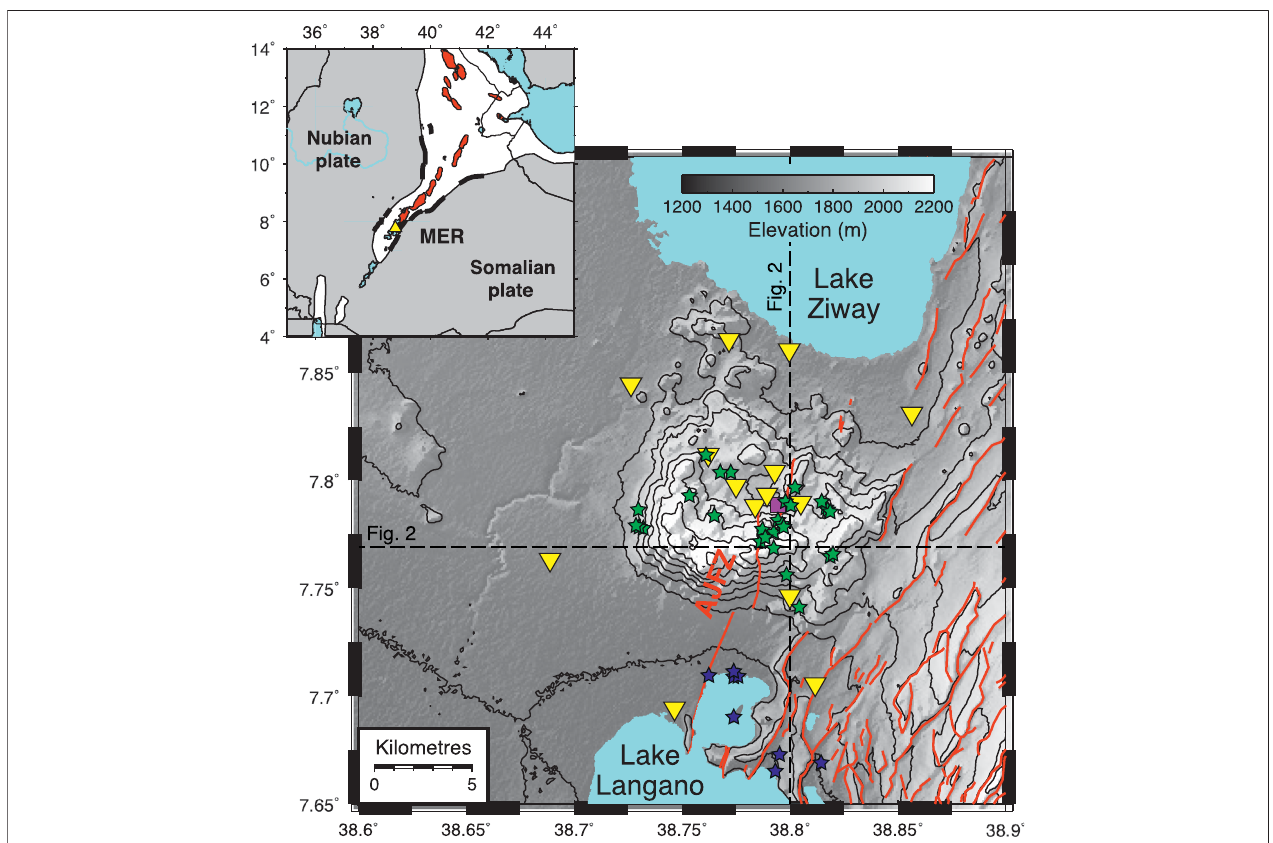
FIGURE1 | The ARGOS seismic network (yellow triangles), faults (red lines) (Agostiniet al., 2011; Hutchison et al., 2015) and the Artu Jawe Fault Zone. Green and bluestarsarefumarolesandhotsprings,respectively(Braddocketal.,2017;Hochsteinetal.,2017).Blackdashedlinesindicatethelocationofthenorth-southandeast- westpro fi lesshownin Figure2 .Inset:Alutoandthestudyregion(yellowtriangle)withintheMainEthiopianRiftwithriftregions(white),borderfaults(thickblacklines)and magmatic segments (red) marked.